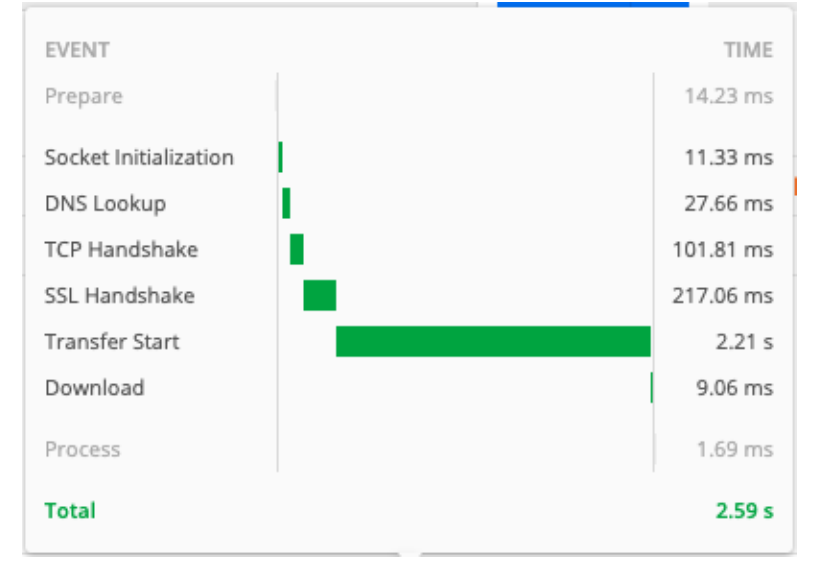
Figure 18. Postman Results for 20 min